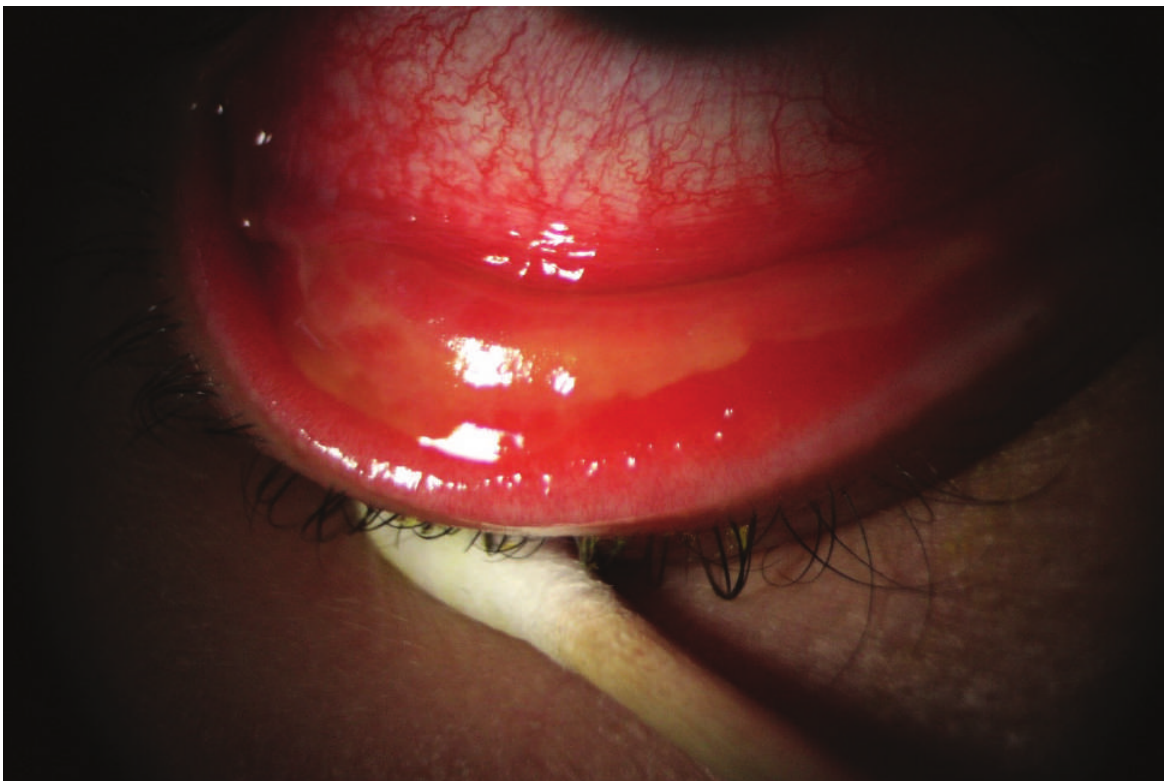
Figure 2. Pseudomembrane formation in a patient with adenoviral